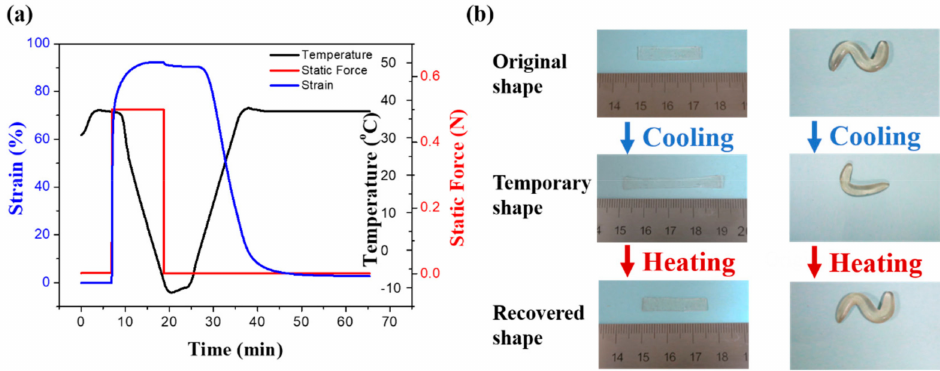
Figure 5. The shape memory properties of PDMS-COO-E. ( a ) Dynamic thermomechanical analysis about shape memory properties. ( b ) Macroscopic images showing the shape-memory functions of the PDMS-COO-E